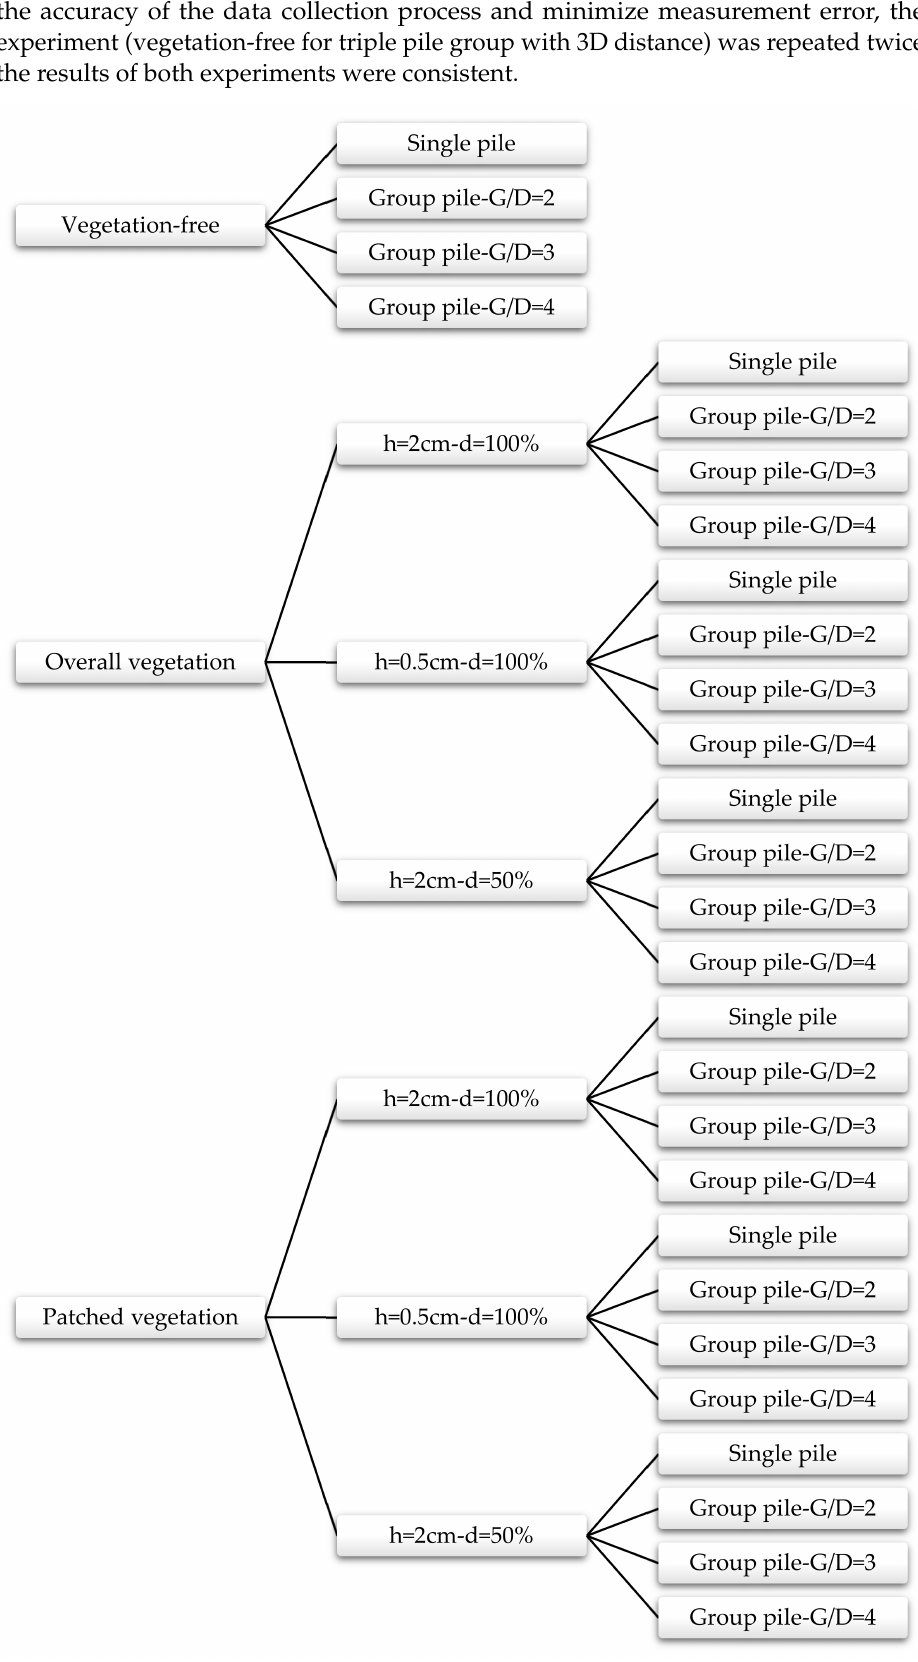
Figure 5. Series of experiments